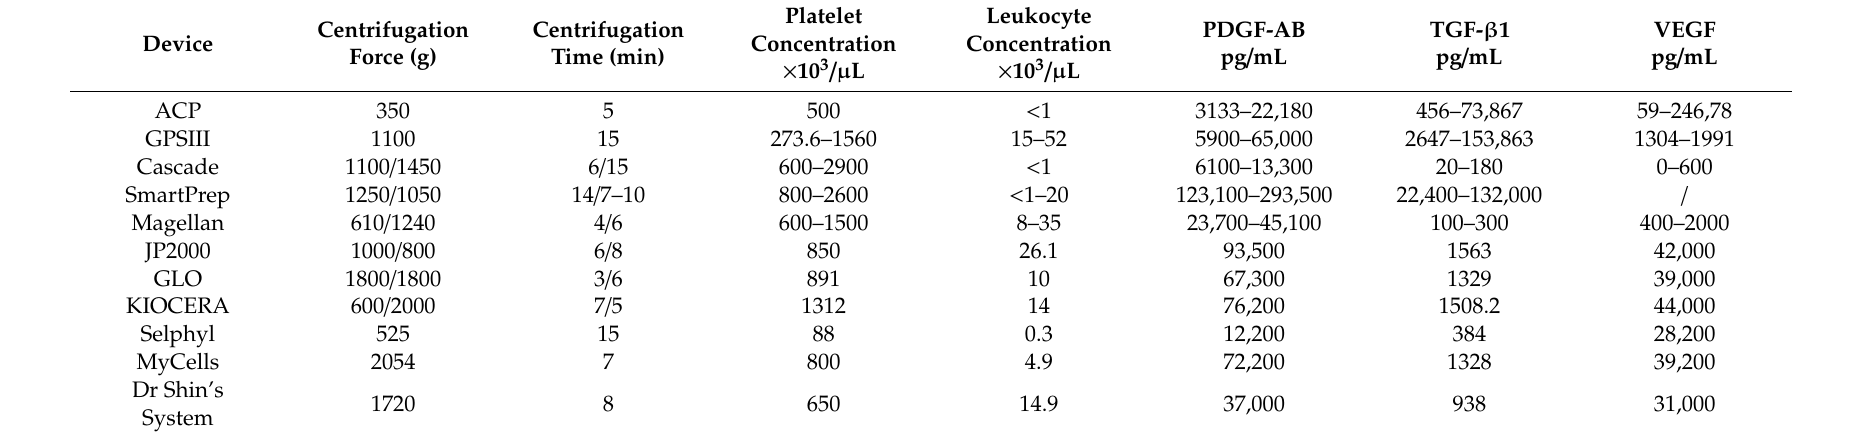
Table 1. Centrifugation protocol and composition of platelet-rich plasma (PRP) produced by common commercial PRP